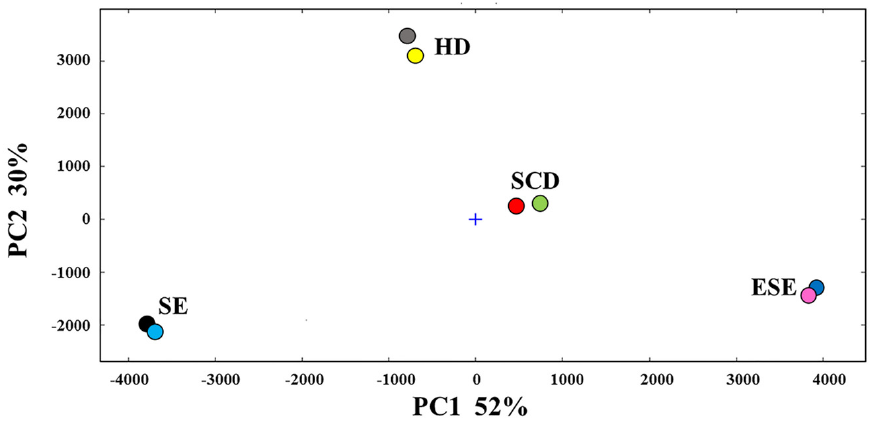
Figure 6. PCA scatter plot of pre-processed GC − IMS spectra for SAEOs extracted by four different methods.